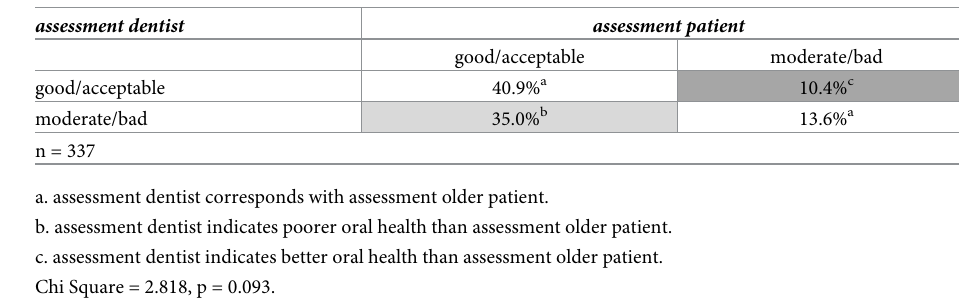
Table 4. Level of oral health of older people who visit the dental practice, assessment dentist in relation to assess- ment